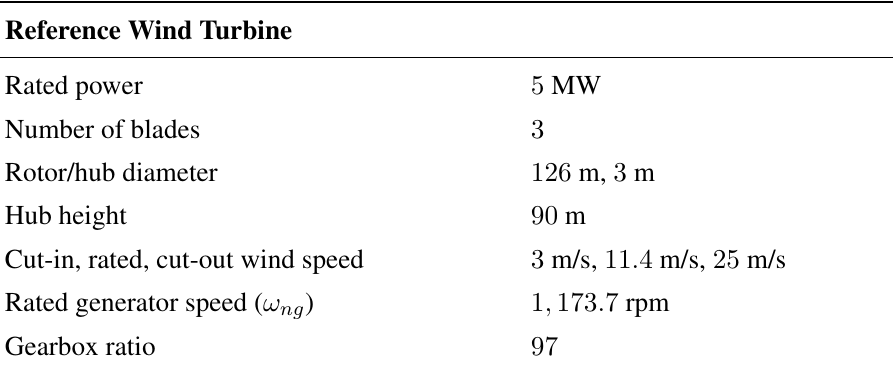
Table 1. Gross properties of the wind turbine